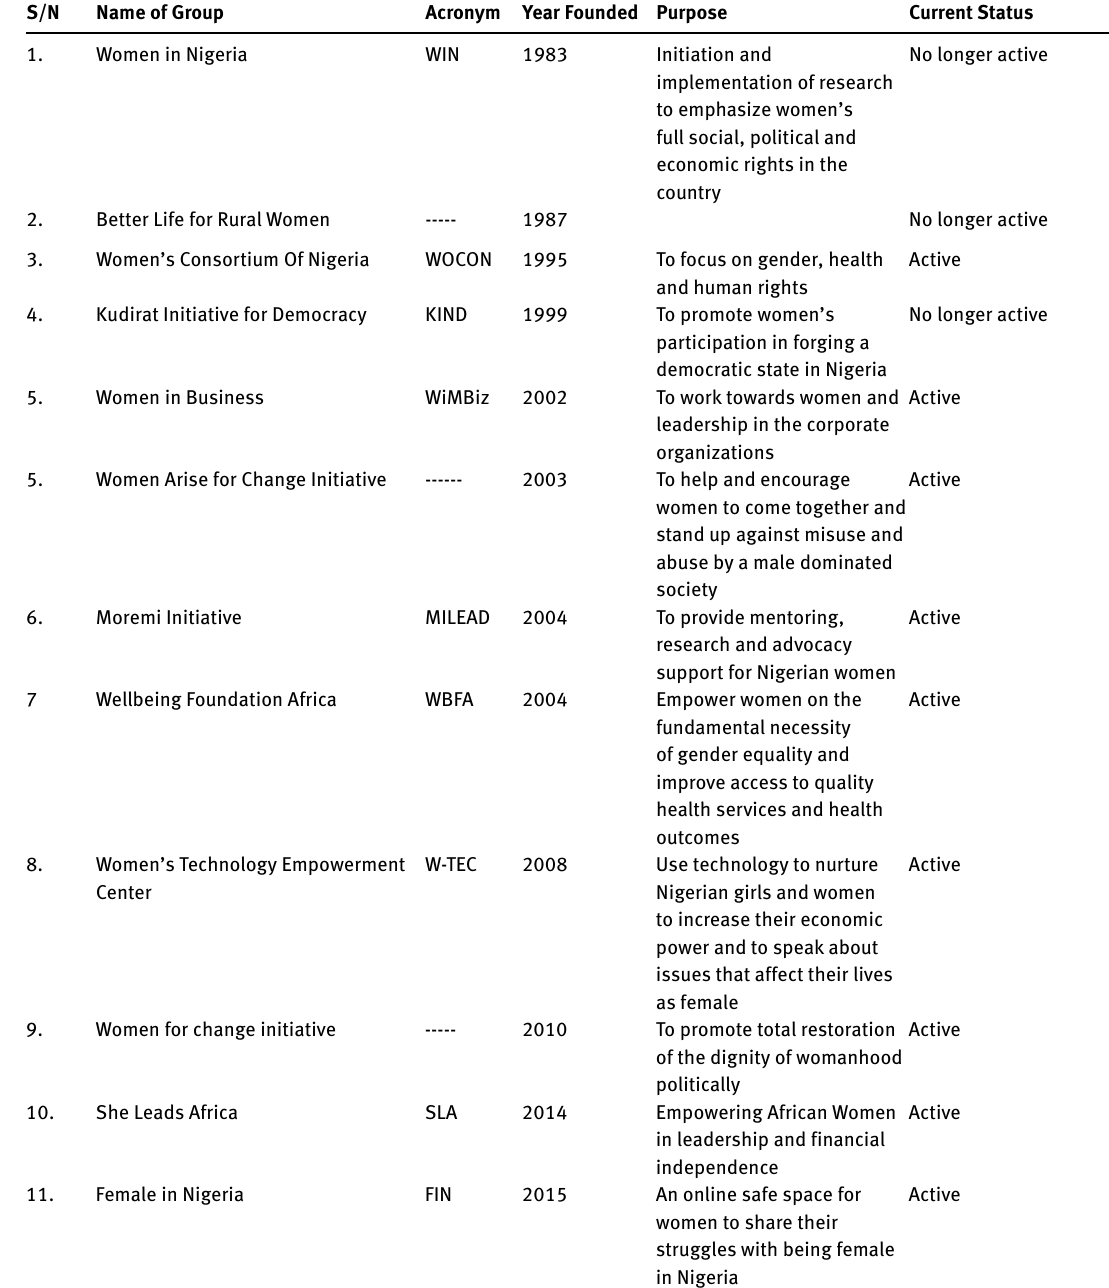
Table 2: Notable Women Groups in the Post-Independence